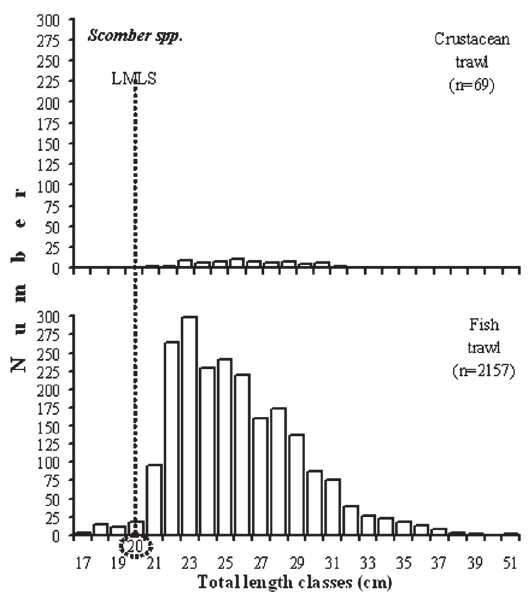
Fig . 9. – length frequency distribution of the fish trawl target spe- Fig . 11. – length frequency distribution of the fish trawl target spe- cies Pagellus spp. (seabream) (lMls=legal Minimum landing cies Scomber spp. (Mackerel) (lMls=legal Minimum landing size). size).